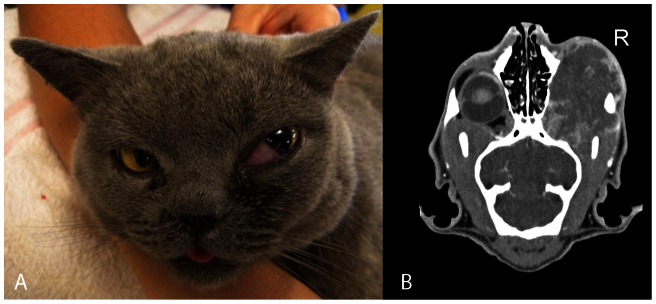
Cat with sino-orbital aspergillosis (invasive fungal rhinosinusitis) caused by A. felis with exophthalmia and prolapse of the nictitating membrane (third eyelid) associated with a retrobulbar fungal granuloma (A).Coronal CT scan soft-tissue post-contrast view showing retrobulbar fungal granuloma occupying the inferior aspect of the orbit with involvement of the adjacent paranasal subcutaneous tissues (B).